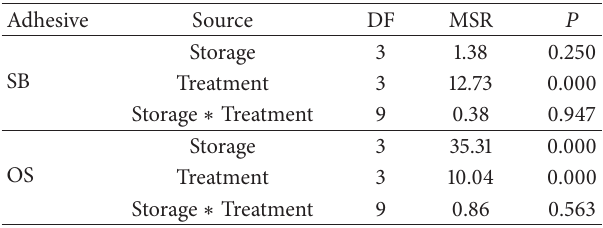
Table 3: Two-way ANOVA for both adhesive systems.